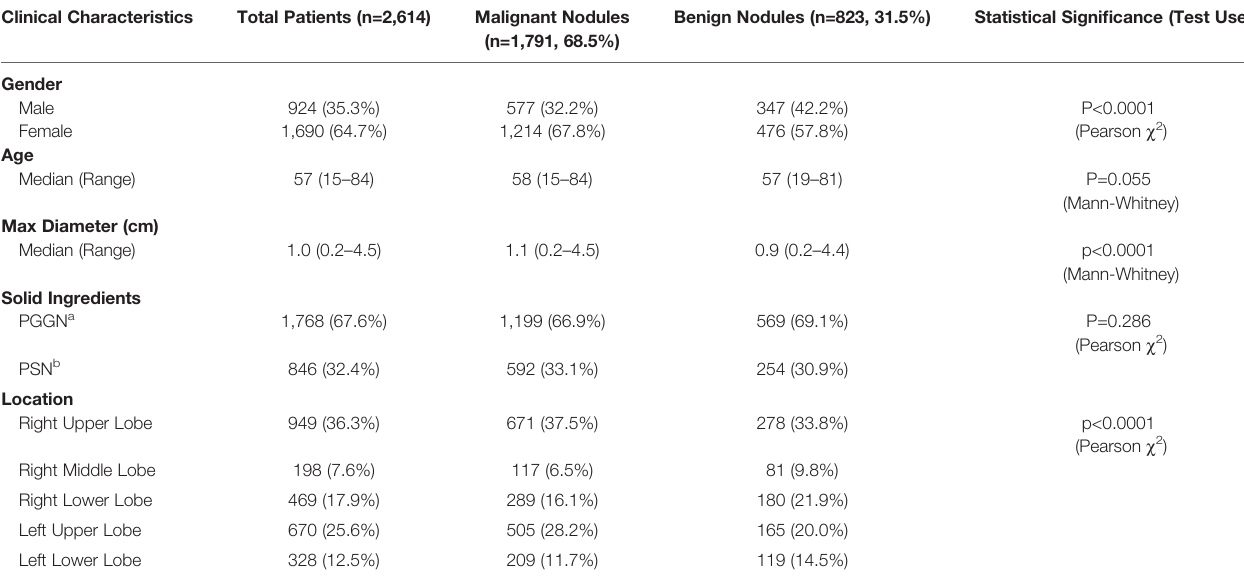
TABLE 1 | Clinical characteristic of total patients.